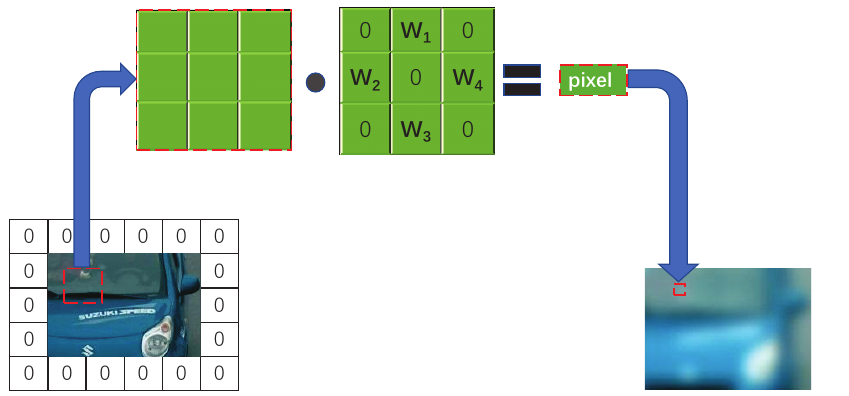
Figure 3. Overview of blur transformation.